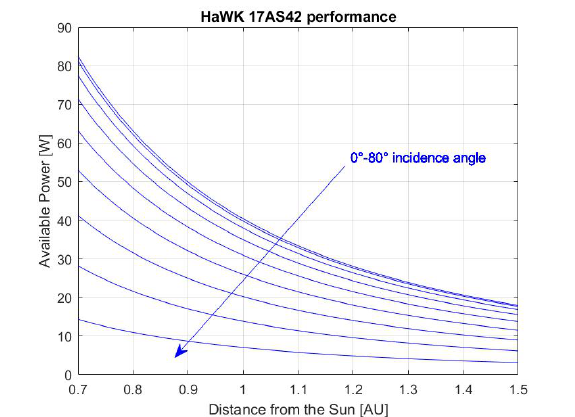
Figure 8. Solar panels BOL available power in function of distance from the Sun and increasing incidence angle 0 ◦ –80 ◦ (from top to